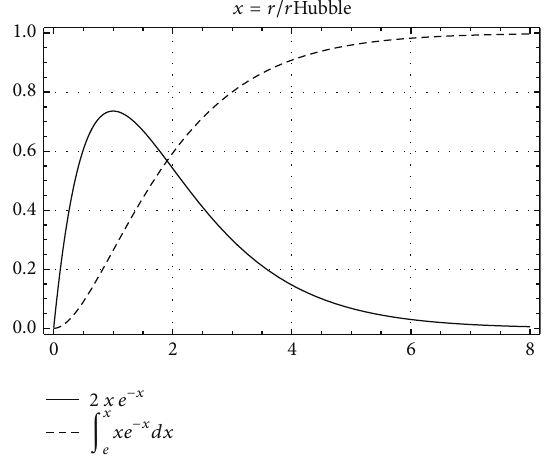
Figure 8: Relative contribution to inertia versus distance: most inertia is generated at distances larger than 𝑟 Hubble.